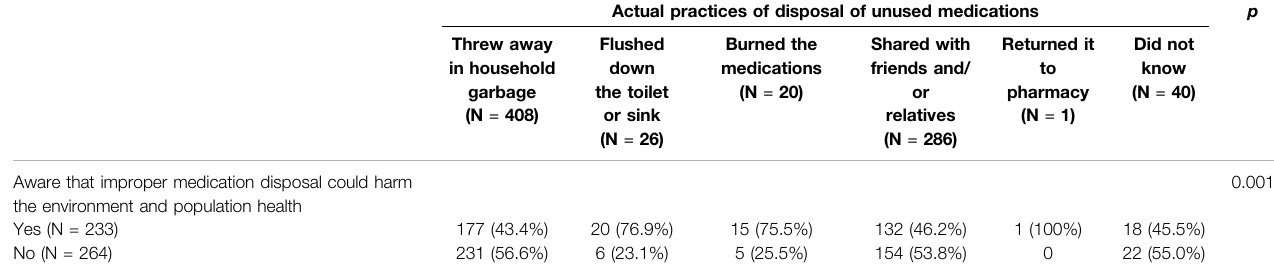
TABLE 4 | Associations between awareness and actual unused medication disposal practices.